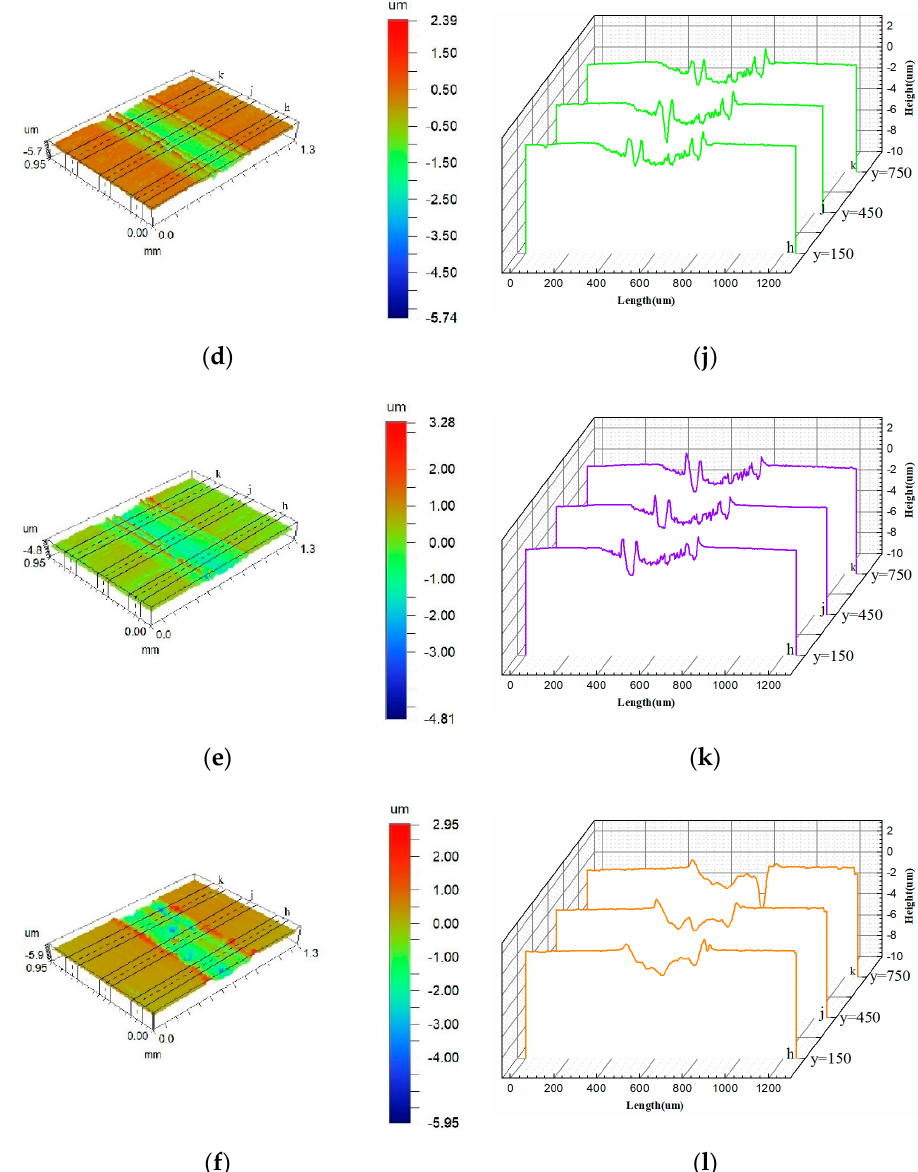
Figure 7. Three-dimensional surface profiles and profile curves of cladding coating after wear tests: ( a ) profile of 0 HCT; ( b ) profile of 3 HCT; ( c ) profile of 6 HCT; ( d ) profile of 9 HCT; ( e ) profile of 12 HCT; ( f ) profile of 24 HCT; ( g ) profile curve of 0 HCT; ( h ) profile curve of 3 HCT; ( i ) profile curve of 6 HCT; ( j ) profile curve of 9 HCT; ( k ) profile curve of 12 HCT; ( l ) profile curve of 24 HCT. 3.5. Wear Factor